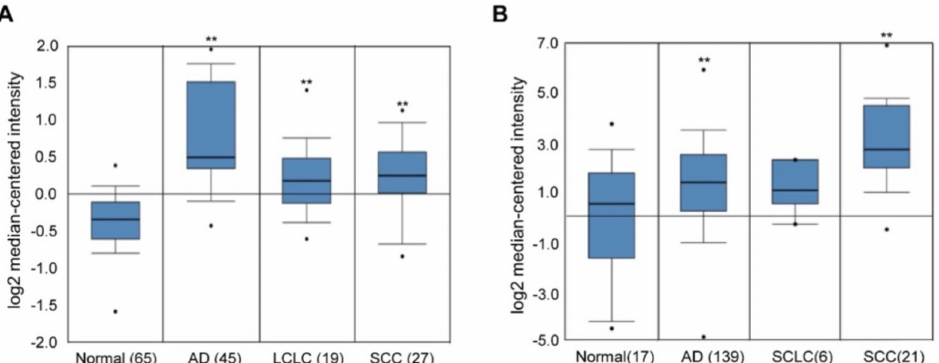
Figure 1. Euchromatic histone-lysine N-methyltransferase 2 (EHMT2) expression in di ff erent types of lung cancer. ( A and B ) Expression of lung cancer datasets for the EHMT2 gene was presented using the Oncomine database. The data were extracted from the Hou lung dataset ( A ) and the Bhattacharjee lung dataset ( B ). EHMT2 expression in di ff erent types of lung cancers was shown in a number of samples. AD: lung adenocarcinoma, LCLC: large cell lung carcinoma, SCC: squamous cell lung carcinoma, SCLC: small cell lung carcinoma. * p < 0.05, ** p < 0.001 against the normal tissues by t